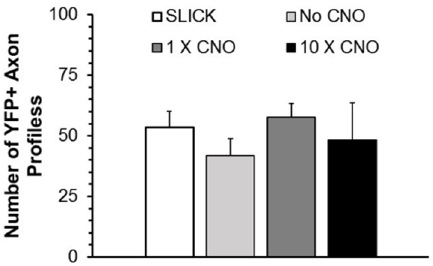
Figure 2. The mean number ( ± SEM, N = 5) of regenerating YPF+ axon profiles found in grafts in the same groups as Figure 1. No Significant differences were found between groups (ANOVA). SLICK: Single neuron labeling with inducible Cre-mediated knockout; CNO: clozapine-N-oxide; YFP: yellow fluorescent protein.